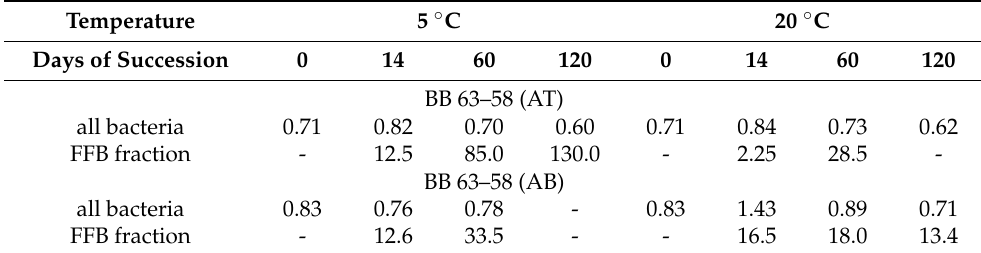
Table 5. Alphaproteobacteria/Acidobacteria